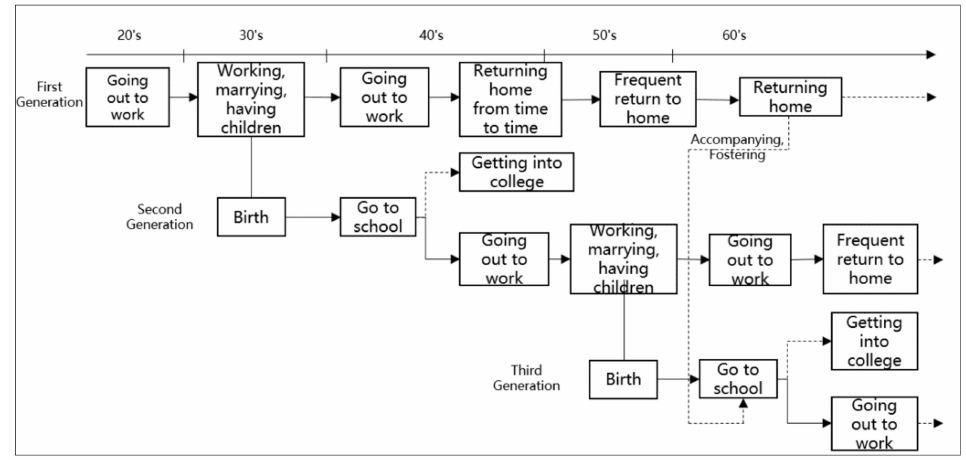
Figure 5. Schematic diagram of multi-stage characteristics in the process of rural urbanization in Chebu